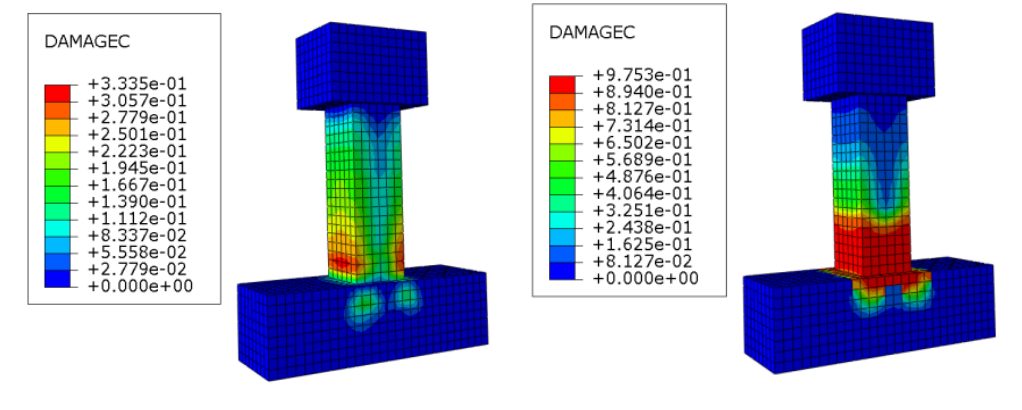
Figure 9: Nephograms of Compression Damage of